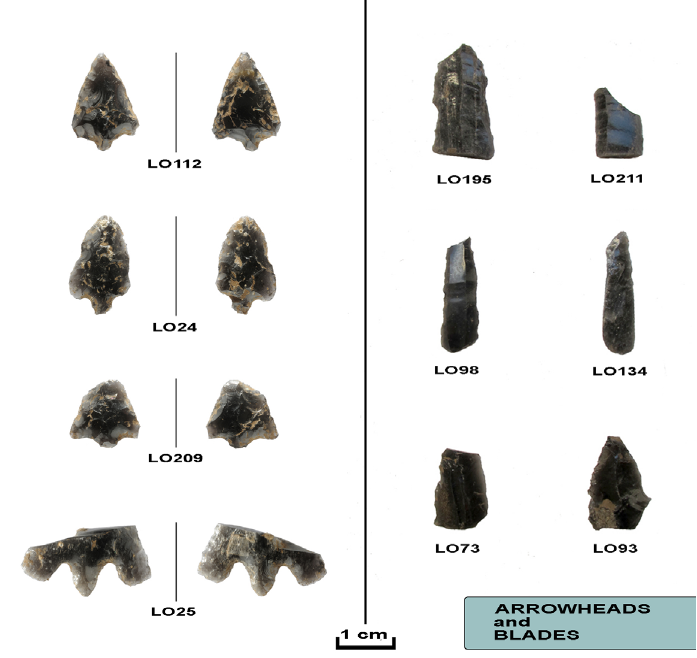
Figure 5. Some of the major typological groups of obsidian analyzed in the S–F